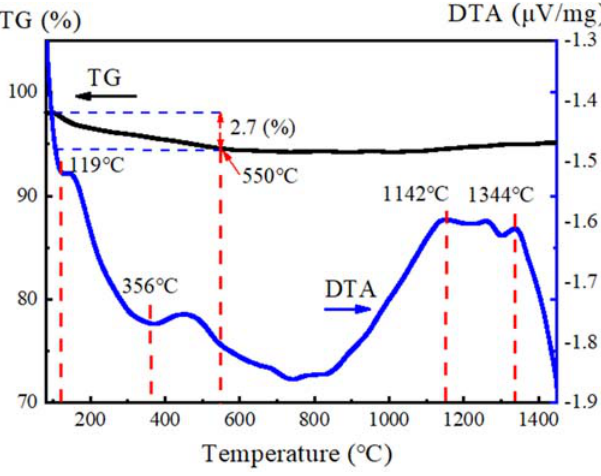
Figure 2. TG − DTA curve of spray granulation powders.